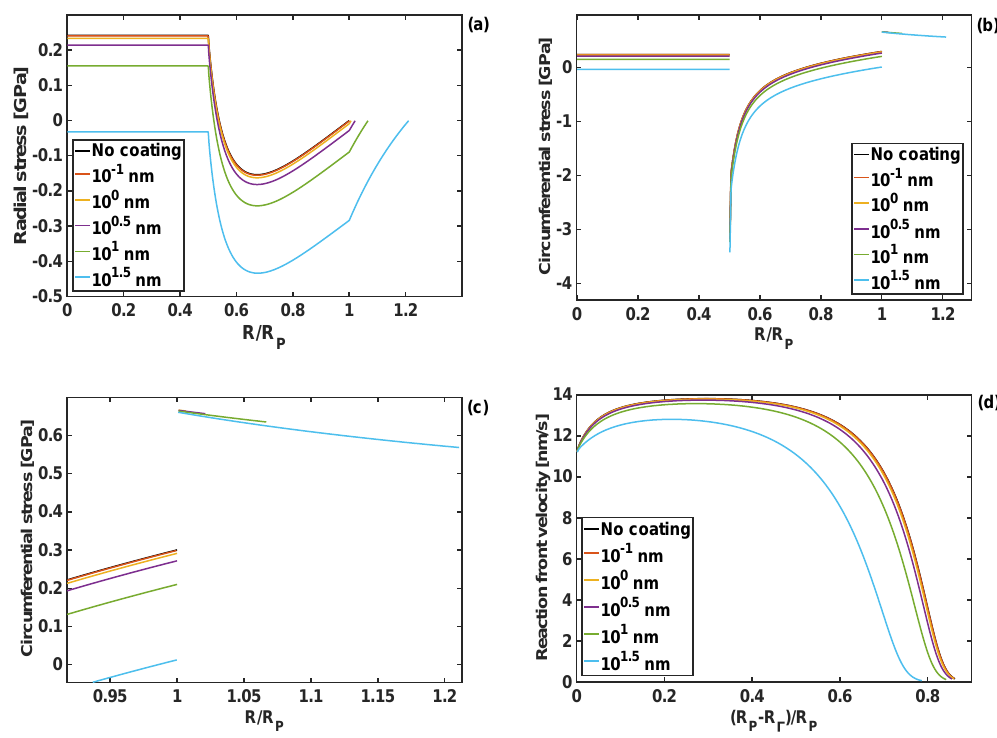
Figure 9: Stresses for different coating thicknesses h= 10 −1  10 1.5 nm, and G T = K T =1 GPa; Figure 9. Stresses for different coating thicknesses h = 10 − 1 ÷ 10 1.5 nm, and G T = K T = 1 GPa; ( a ) radial stresses; ( b ) zoom-on of radial stresses; ( c ) circumferential stresses; ( d ) reaction front (a) radial stresses, (b) zoom-on of radial stresses; (c) circumferential stresses; (d) reaction front velocity.